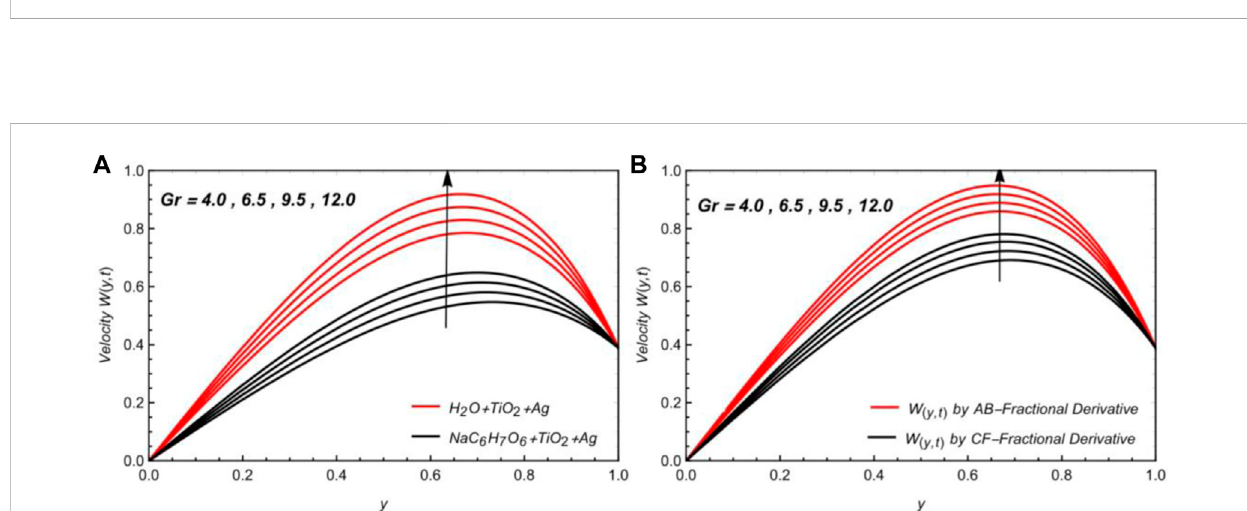
FIGURE 6 W ( y , t ) due to variation in K eff with α , β (cid:2) 0 . 5 , φ (cid:2) 0 . 02 , M (cid:2) 1 . 65 , Ra (cid:2) 1 . 2 , Gr (cid:2) 8 . 0 , Gm (cid:2) 6 . 3 , β 1 (cid:2) 1 . 5 , θ (cid:2) π /4 , and t (cid:2) 0 . 8.